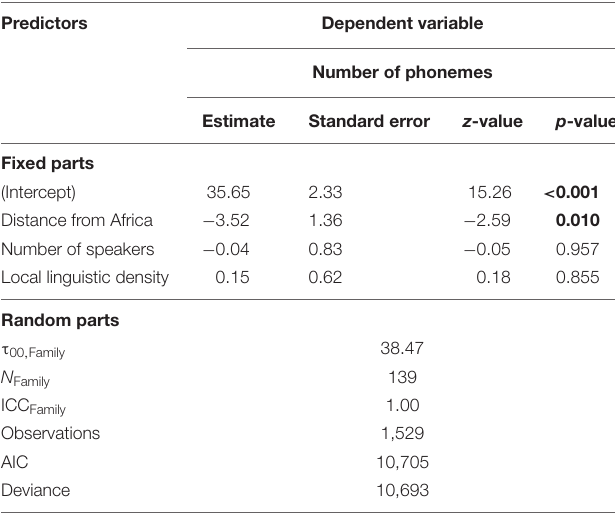
TABLE 2 | Output of an inverse-Gaussian GLMM applied to the